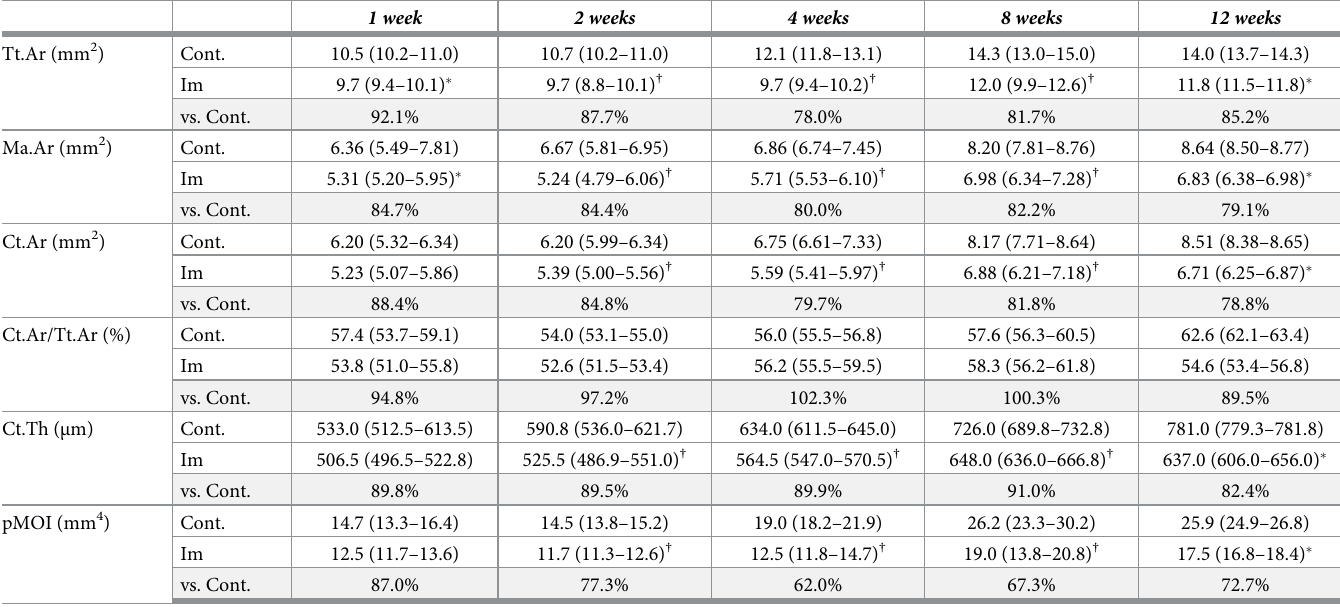
Table 1. Cortical bone parameters in the midshaft of the femoral bone for the two groups at all time points. 1 week 2